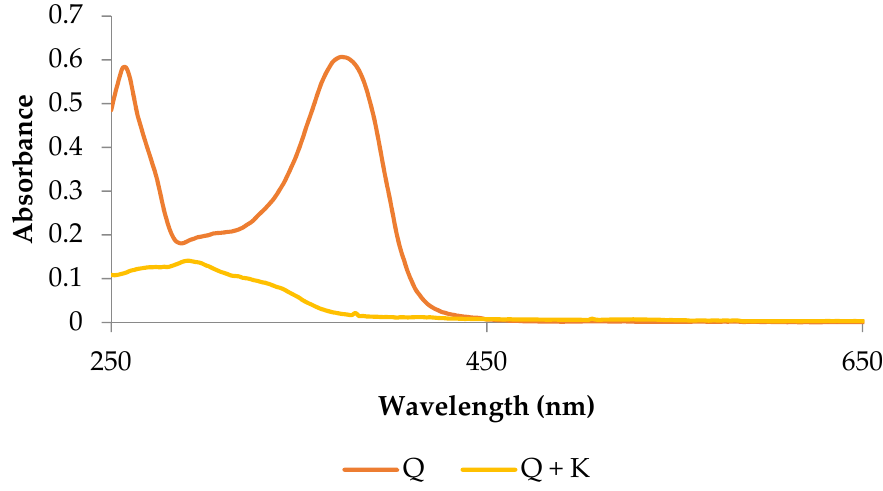
formation of derivatives (Figure 2).